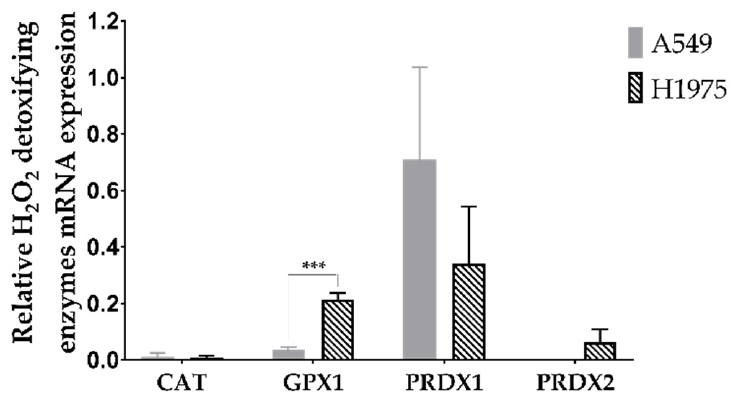
Figure 2. Gene expression analyses of the main H 2 O 2 detoxifying enzymes. Values represent mean ± SD ( n = 3) and are normalized to the reference gene β -ACTIN. *** p < 0.001 (Student’s t -test).